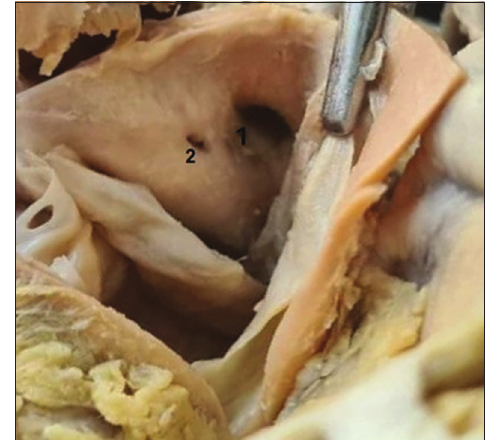
FIGURE 3. Right coronary artery (RCA) and third coronary artery (TCA) orifice in the right aortic sinus (1. RCA and 2. TCA).